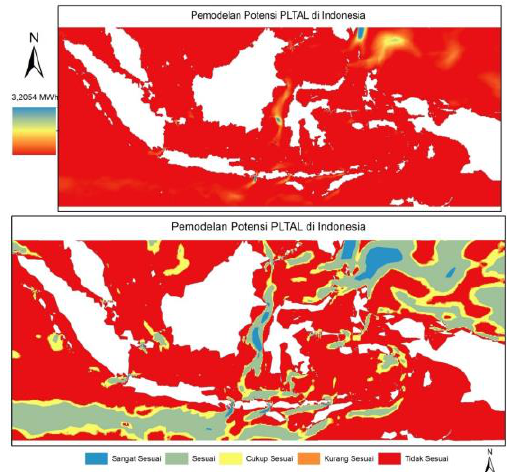
Figure 3 Effective power potential modeling results